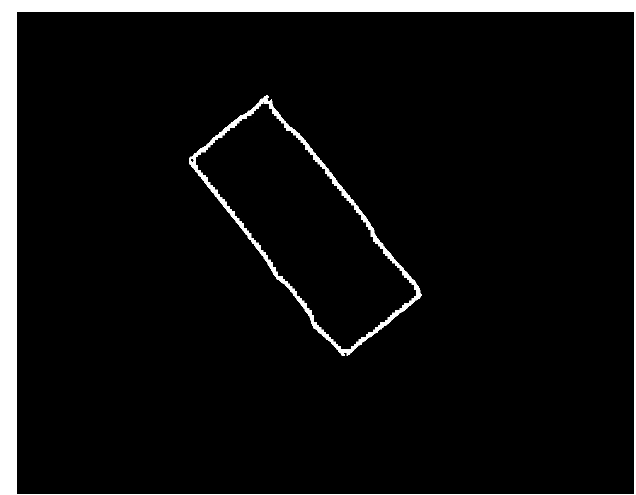
Polymers 2023 , 15 , x FOR PEER REVIEW 10 of 24